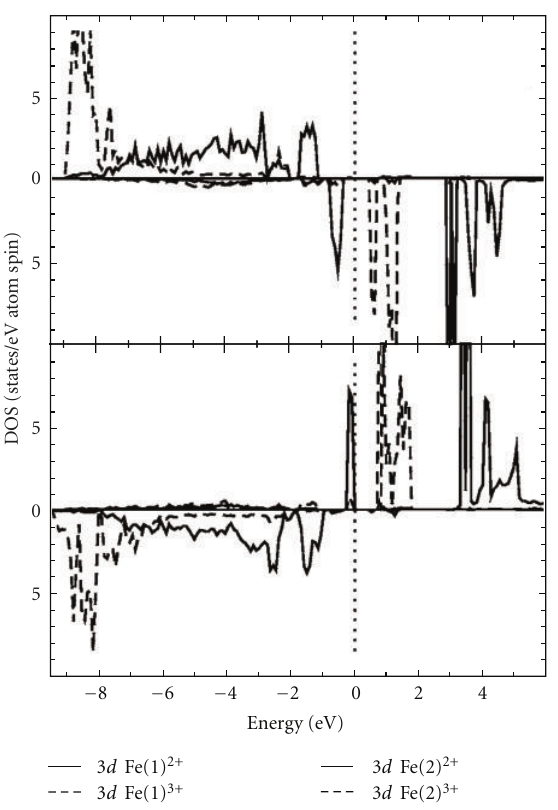
Figure 16: The partial DOSs for di ff erent Fe cations are shown. The gap is opened between Fe(2) 2+ and Fe(2) 3+ for majority spin and Fe(1) 2+ and Fe(1) 3+ cations for minority spin states. The gap value of 0.39eV was obtained by LSDA+ U with U = 5 . 5 eV and J = 1 eV [211]. The Fermi level is shown by dotted